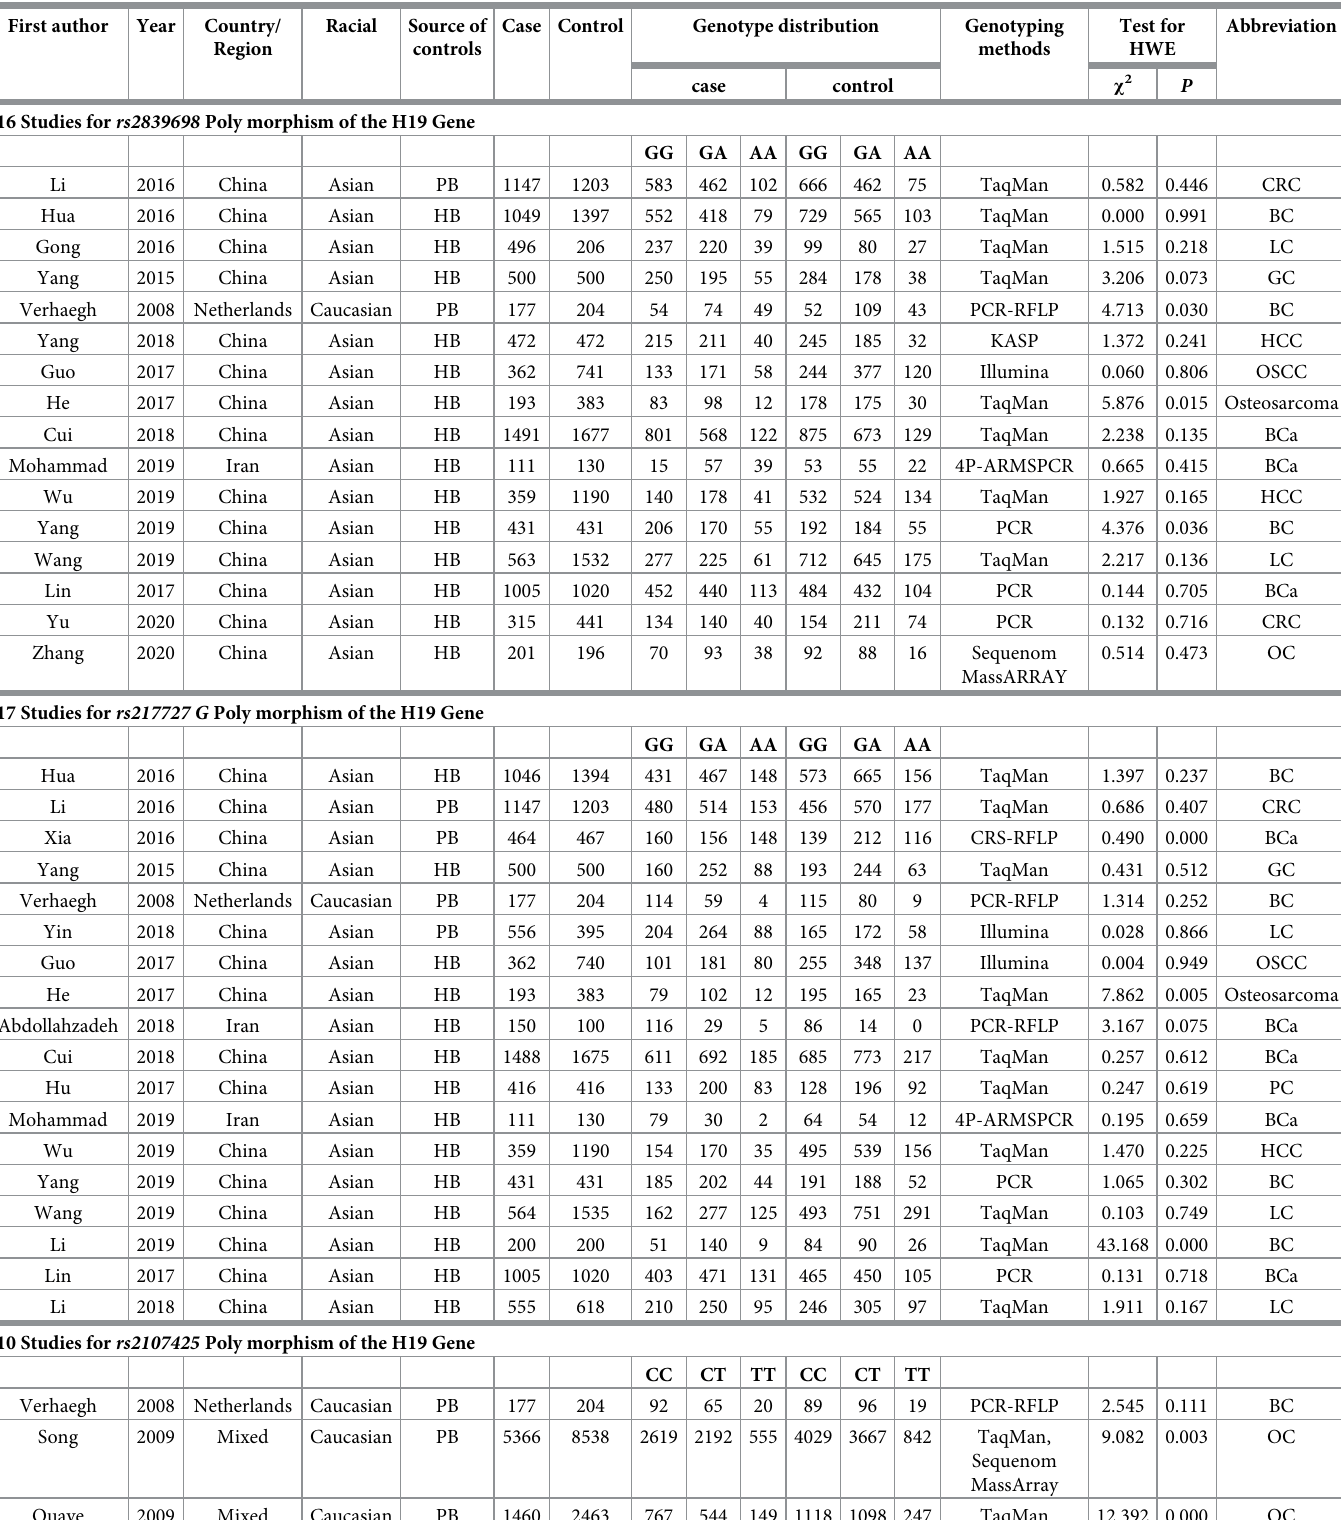
Table 1. Characteristics of individual studies included in the